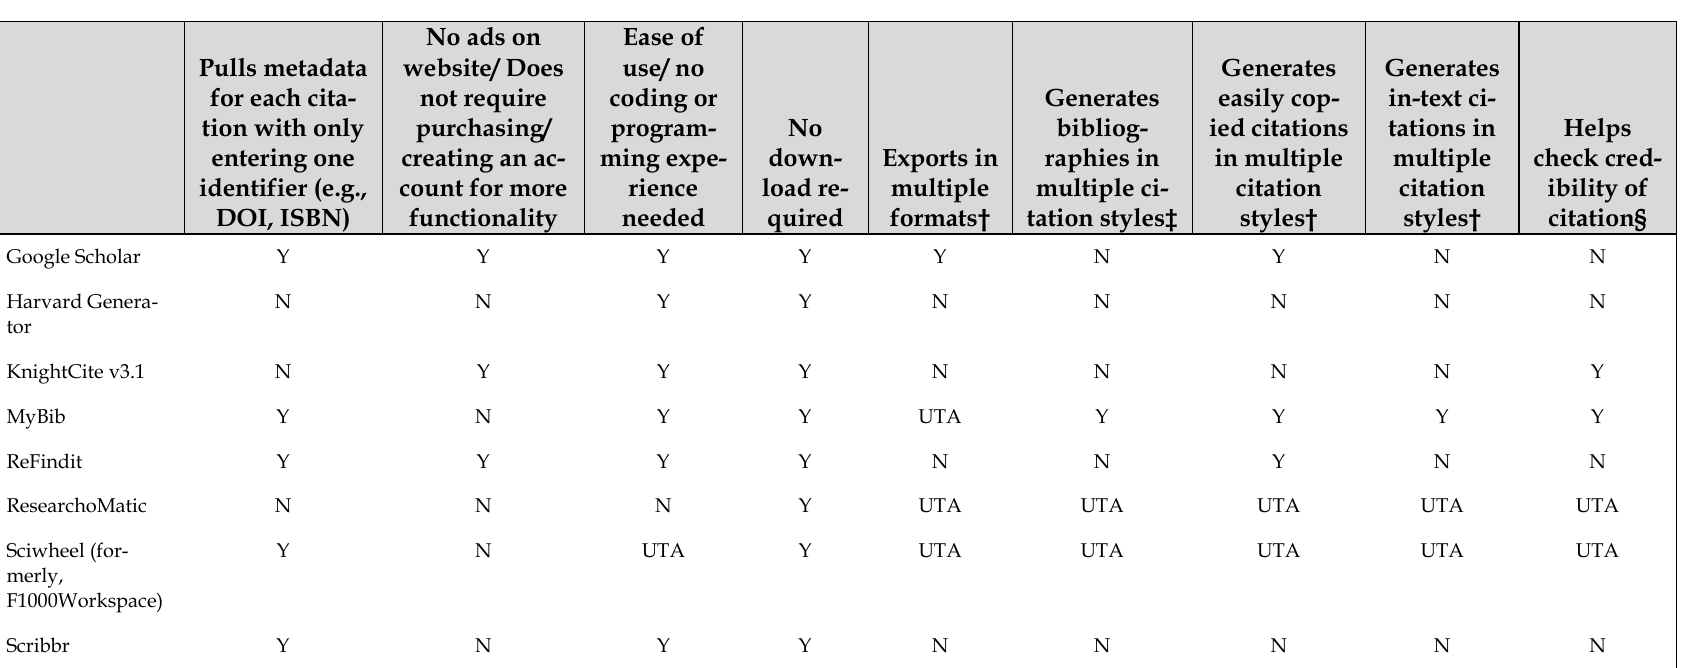
Table 1 Overview of features of different citation generators